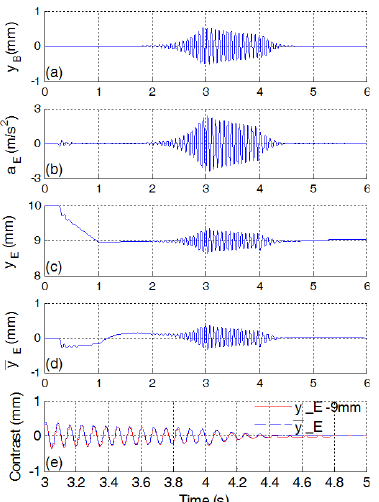
Figure 11. The numerical verification for vibration suppression method, which is activated at t = 4 s: ( a ) the displacement of bridge; ( b ) the displacement of electromagnet; ( c ) the estimated displacement of electromagnet, and ( d ) the contrast signals of the estimated and the real displacement of